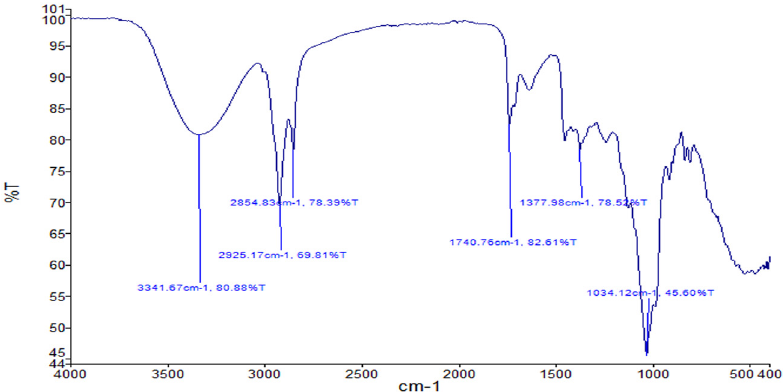
Figure 12: FTIR spectra of the crude methanol extract of Trillium govanianum .